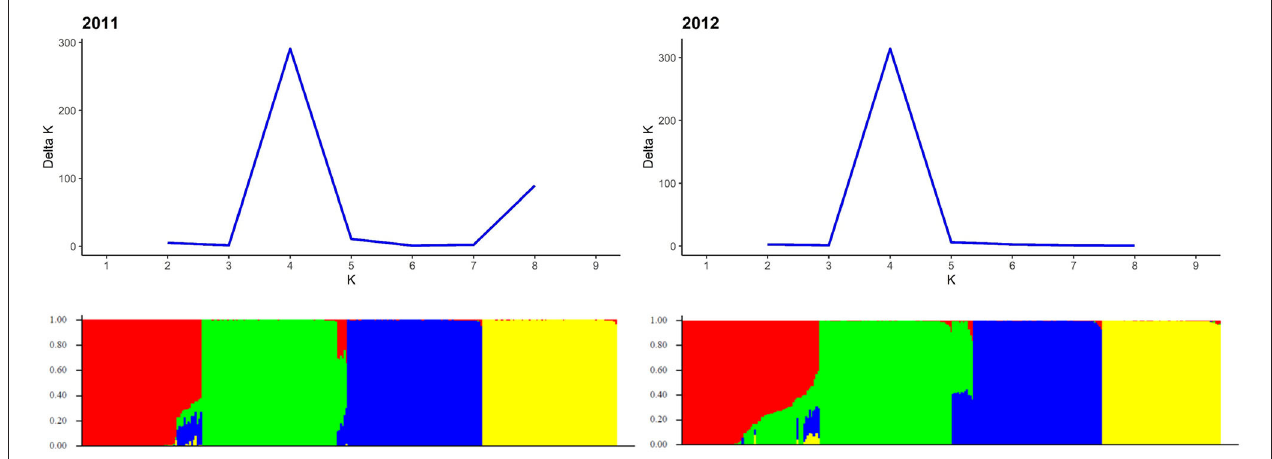
FIGURE 5 | Population structure based on genotyping data of 1,523 and 4,000 SilicoDArT TM markers for 298 and 305 single cross rye hybrids in 2011 and 2012, respectively. Each genotype is represented by a thin vertical line, which is partitioned into k = 4 colored segments that represent the genotype’s estimated membership fractions shown on the y-axis in k clusters. Genotypes were sorted according to populations along the x-axis. Determination of the most probable number of k-groups according to Evanno et al. (2005) is displayed in the upper part of the graph.